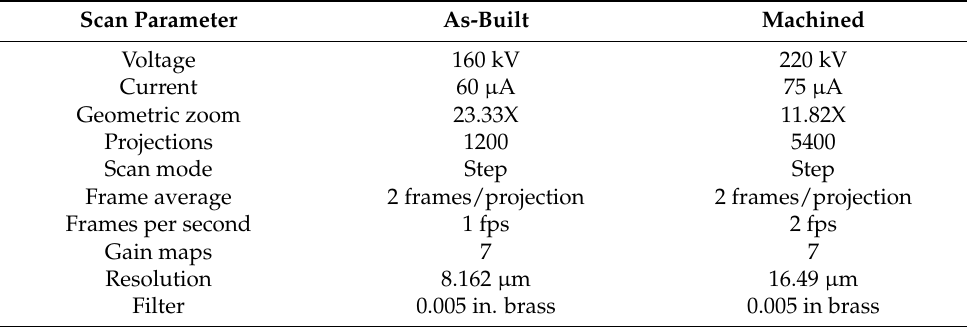
Table 2. Parameters used for scanning as-built fatigue